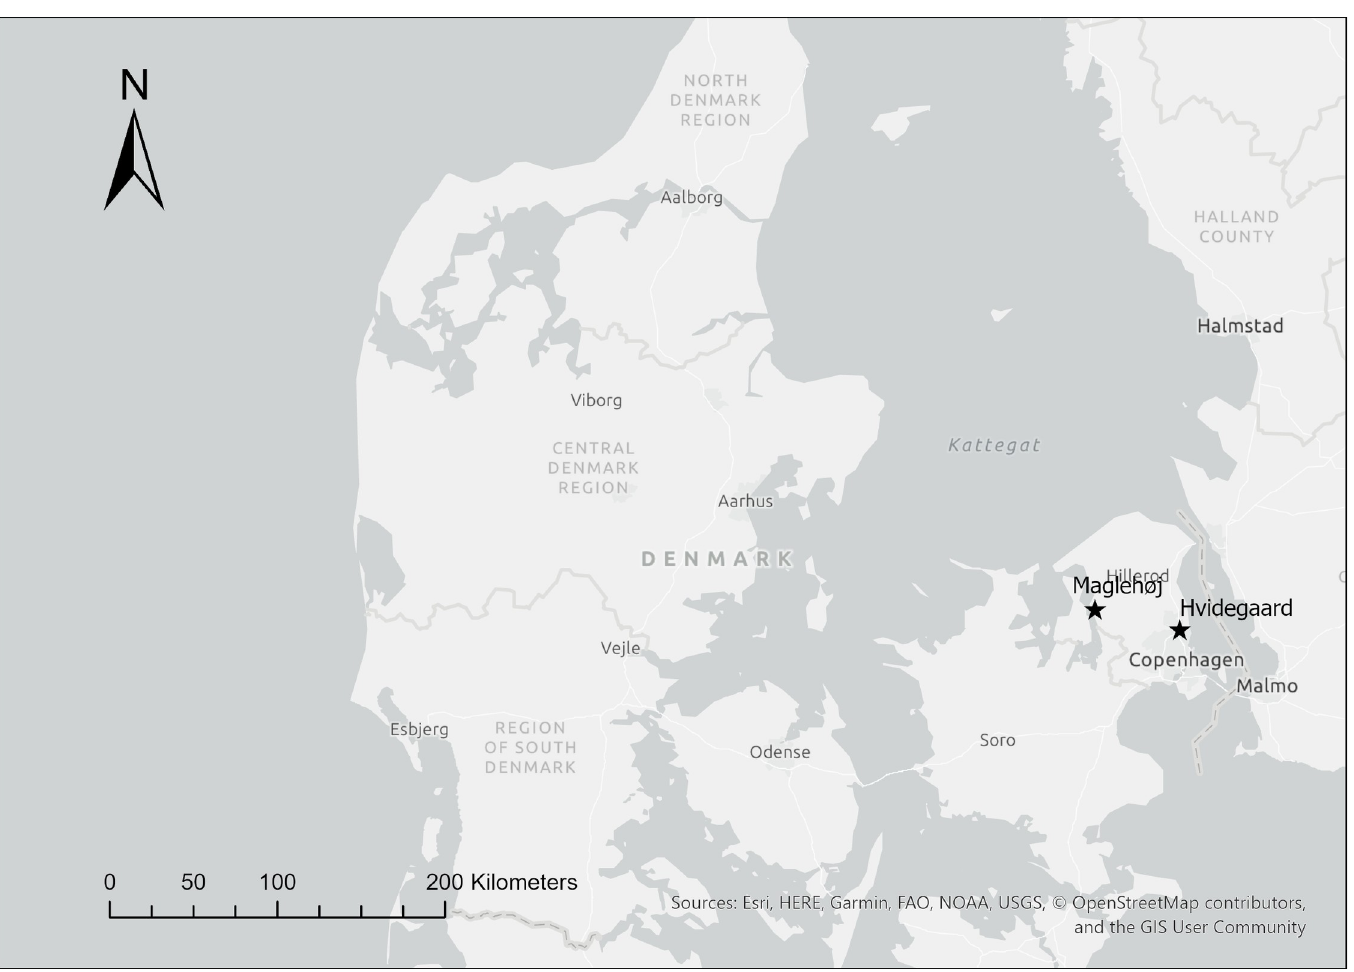
Fig 2. Map showing locations of the Early Nordic Bronze Age sites analyzed within this paper from Zealand, Denmark. This map was generated using ESRI ArgGIS Pro software and basemaps, licensed to the National Museum of Denmark. The base map and data are from OpenStreetMap and OpenStreetMap Foundation.